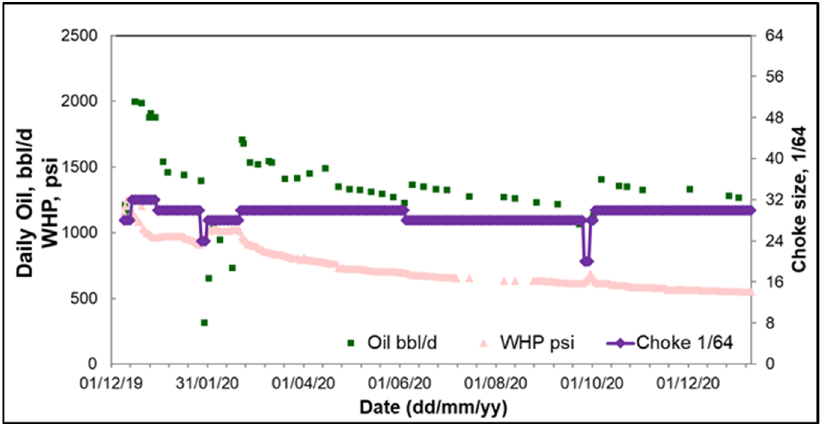
Figure 12. Production performance of well